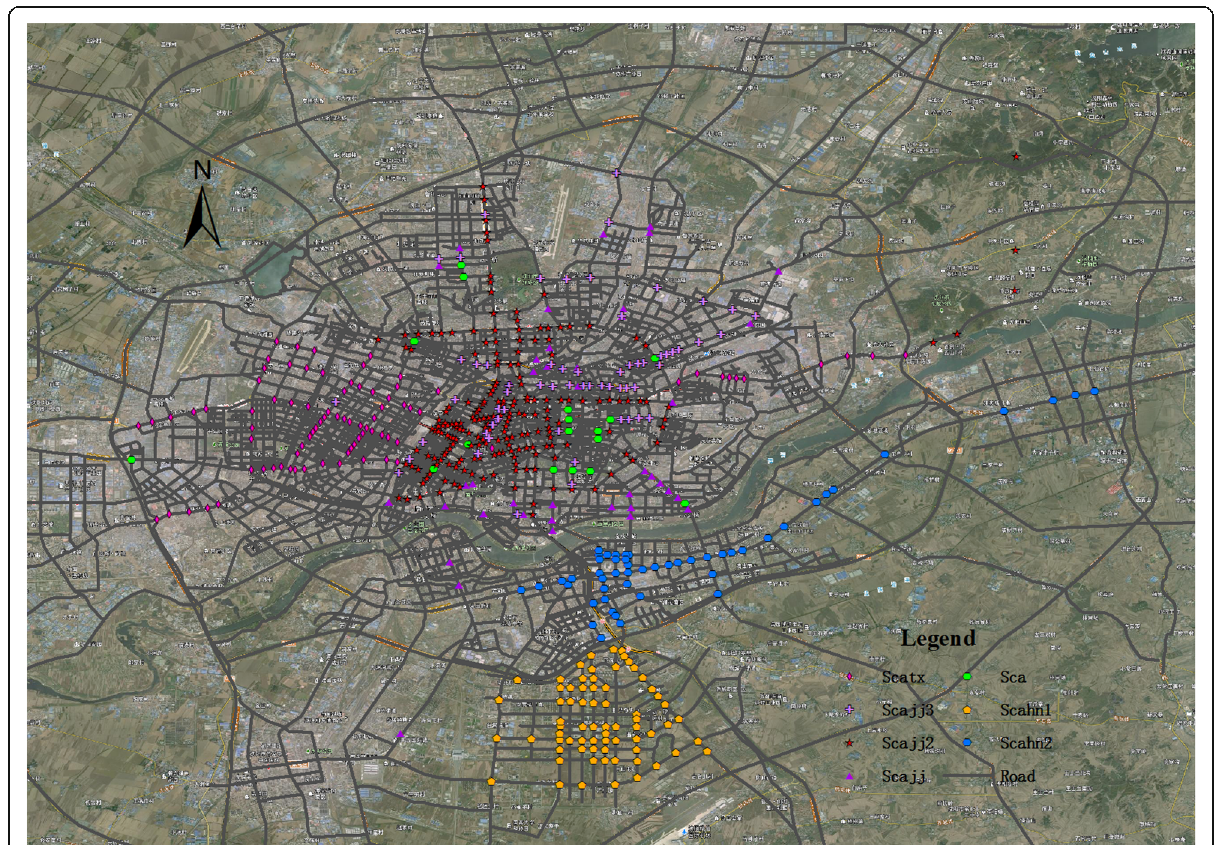
Fig. 1 Intersection distributions controlled by SCATS in Shenyang,